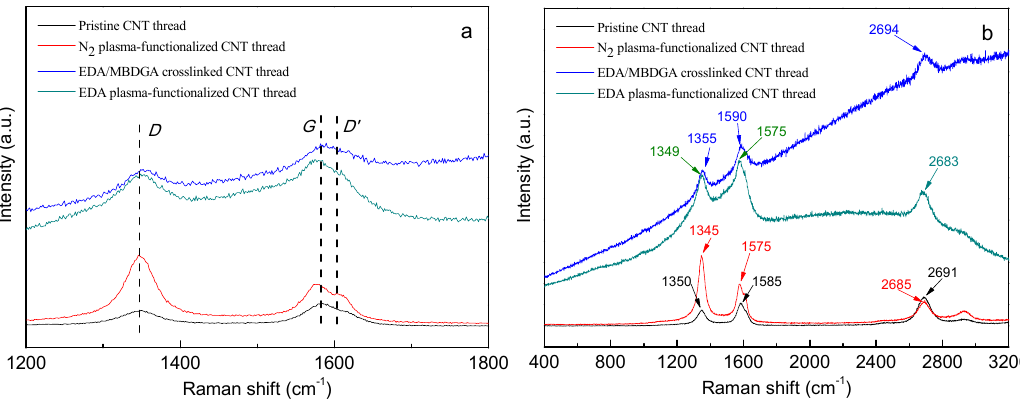
Figure 5. Raman spectra (514 nm) of pristine, plasma functionalized, EDA/MBDGA cross ‐ linked MWCNTs threads; ( a ) shows Raman shifts of main peaks D, G, and D’ at pristine state and after functionalization of MWCNTs; ( b ) larger Raman shift window visualizing Raman shifts for each peak and the shift of G peak after functionalization.